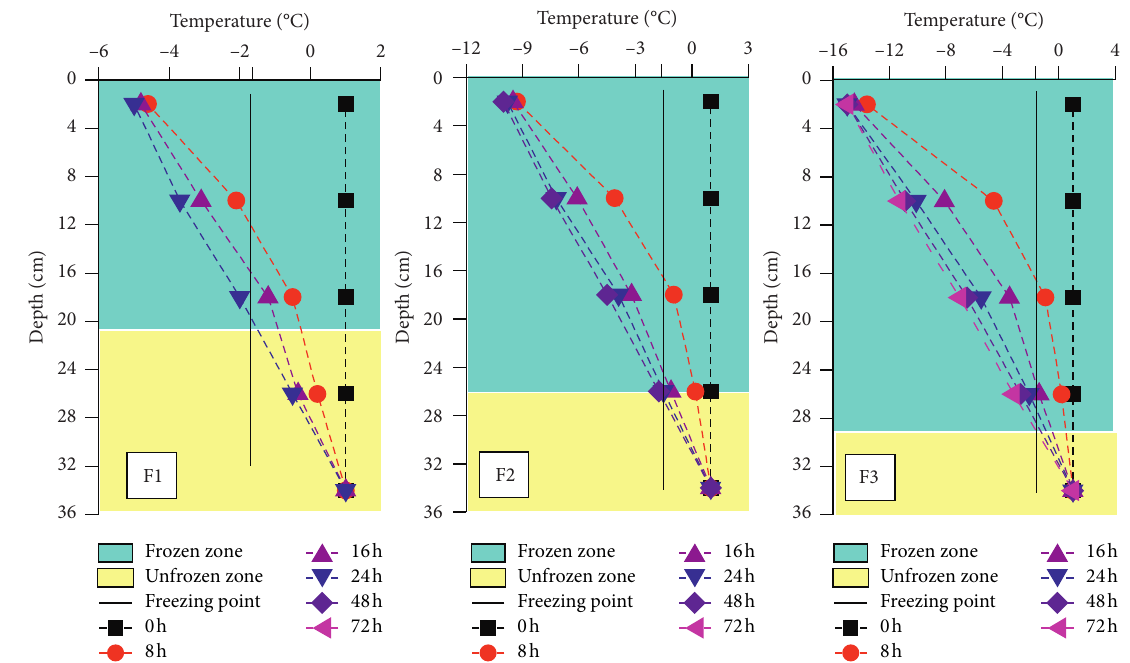
Figure 2: Temperature profiles of the expansive soil columns during the freezing process.